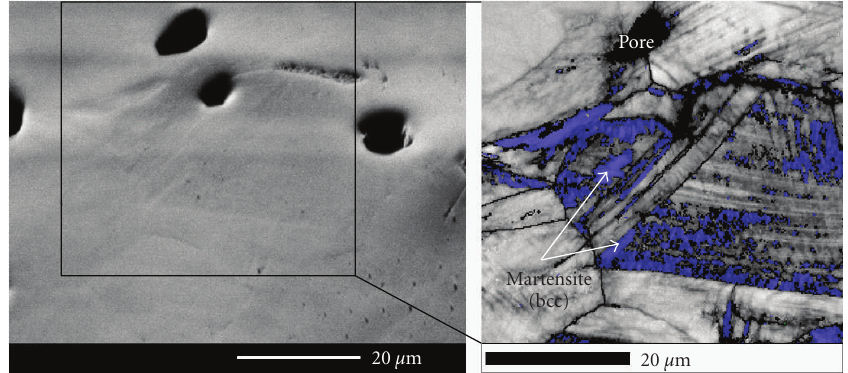
Figure 5: SEM image and EBSD mapping of a zirconia-free (0Z) honeycomb sample after quasistatic compression up to 10% engineering strain (austenite with slip bands: grey shaded, bcc martensite: blue, high angle grain boundaries, and pores: